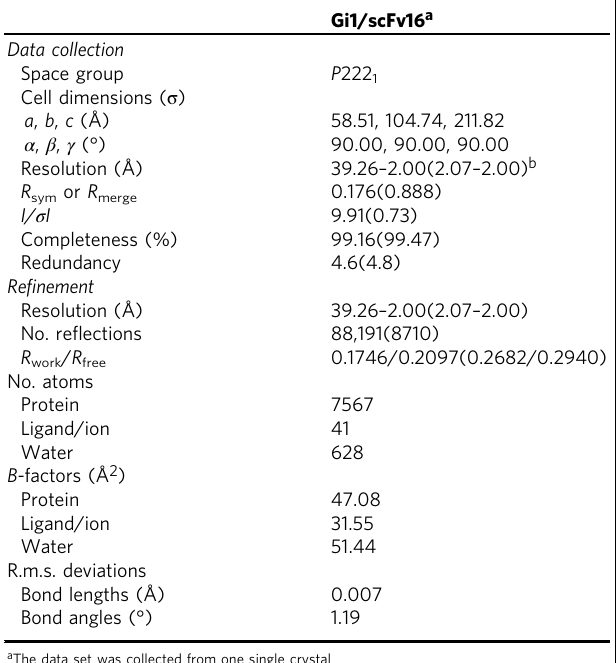
Fig. 1 Isolation of mAb16 and its binding pro fi le to each component. a Analytical SEC of rhodopsin/G i1 with each antibody. Rhodopsin/G i1 runs at 8.2 mL and each mAb alone runs 8.4 – 9 mL ( c ). Rhodopsin/G i1 bound to mAb makes higher molecular weight product and migrates at the elution volume of 6 – 7 mL depending on the mAb. b Analytical SEC of rhodopsin/G i1 with each antibody following to GTP γ S treatment. Intact complex remains at 6 – 7 mL only in the mAb16 condition. c Analytical SEC of individual component of rhodopsin/G i1 or heterotrimeric G i1 with each antibody. Top left: Binding experiment with G α i1 subunit and each mAb. The peak of G α i1 at 11 mL stays intact indicating there is no binding with each mAb. Top right: Binding experiment with opsin. Both mAb peaks and Opsin peak (at 9.5 mL) stays intact. Bottom left: Binding experiment with G βγ subunit. The peak of G βγ at 11.2 mL disappears upon incubating with mAbs except mAb16 and each mAb peak shifts towards left compared to the ones with G α i1 or opsin indicating those mAbs recognize G βγ subunit as an epitope. Bottom right: Binding experiment with heterotrimeric o type G-proteins but not G s , as it has poor sequence similarity to Table 1 Data collection and re fi nement statistics G i/o members at this epitope region (Fig. 3b).